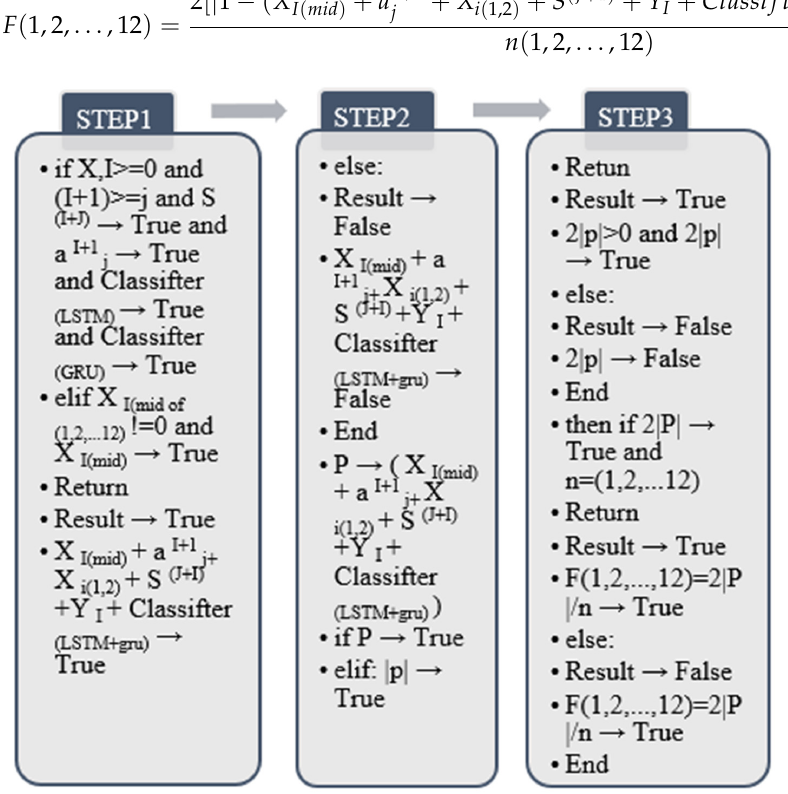
Figure 19. Output diagram of wearable sensor algorithm